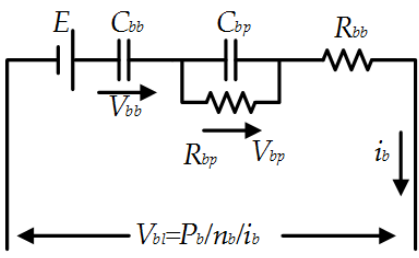
Figure 2. Battery PNGV model.